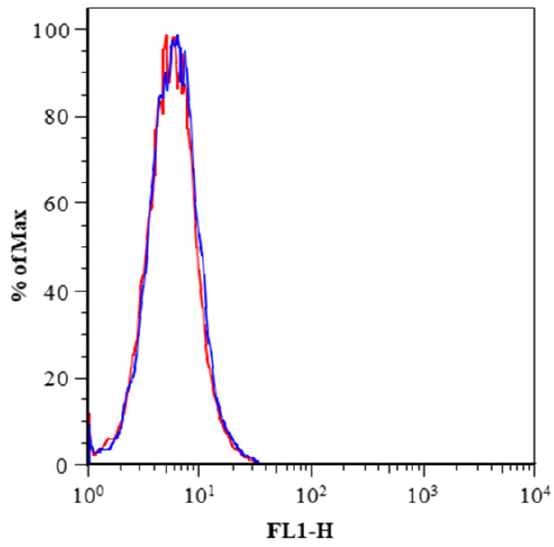
Figure 6. Citofluorimetric detection of membrane uPAR in BHT-101 cells treated with WX-340 compared to control cells.